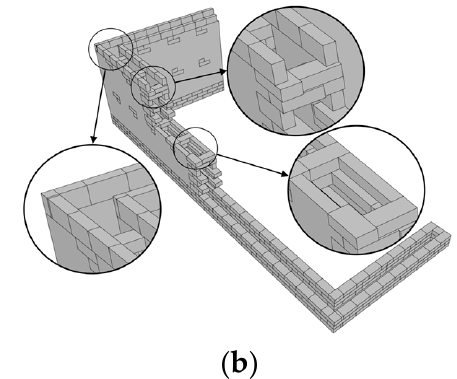
Figure 3. Stone unit layout for ( a ) double-leaf wall specimen (dimensions in mm) and ( b ) three-leaf wall specimen (the middle of the wall was filled with rubble).